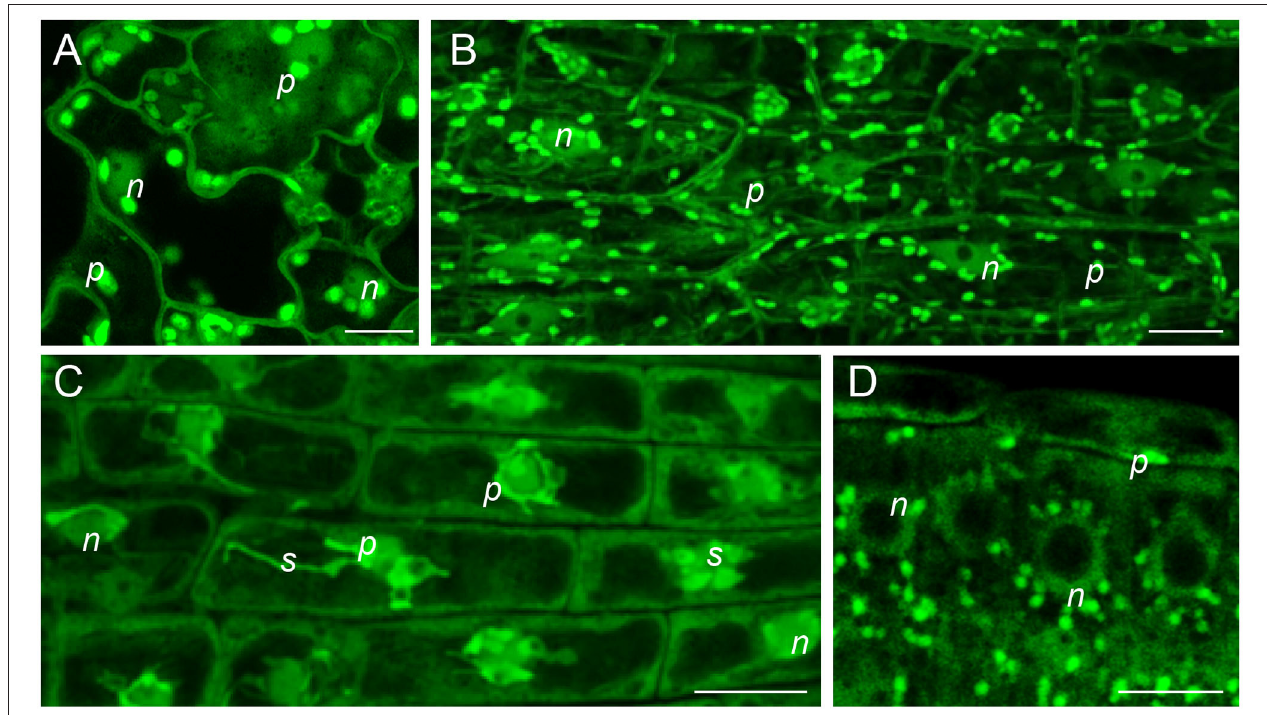
FIGURE 5 | In vivo subcellular localization of FSD1-GFP in plastids, nuclei and cytoplasm of 4-day-old Arabidopsis fsd1-1 mutant harboring proFSD1::FSD1:GFP construct ( Dvo ˇ rák et al., 2020) as revealed by confocal laser scanning microscope equipped with an Airyscan detector. (A) Pavement cells of leaf epidermis; (B) epidermal cells of hypocotyl; (C) lateral root cap cells; (D) root meristematic cells. n, nucleus; p, plastid; s, stromule. Scale bars: (A , C , D) 10 µ m; (B) 20 µ